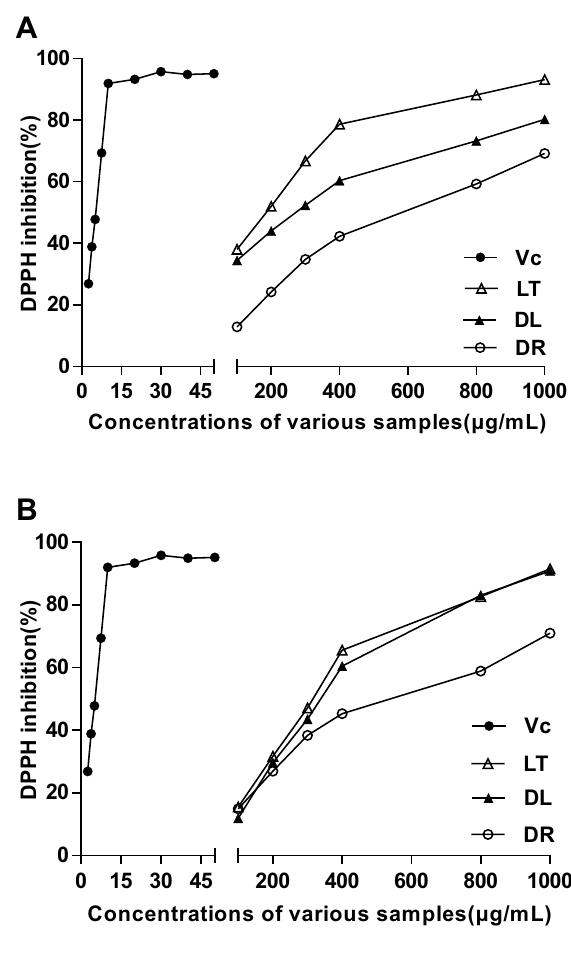
Figure 3. Inhibition of 2,2-diphenyl-1-picrylhy-drazyl (DPPH) radical for water-soluble extracts samples ( A ) and ethanol-soluble extracts samples ( B ) from DL (filled triangle), processed LT (open triangle) and medicinal DR (open circle) of A. membranaceus , compared with Vc (closed circle)); DL, dry leaves; LT, leaf tea ; DR, dry roots; Vc, vitamin C.